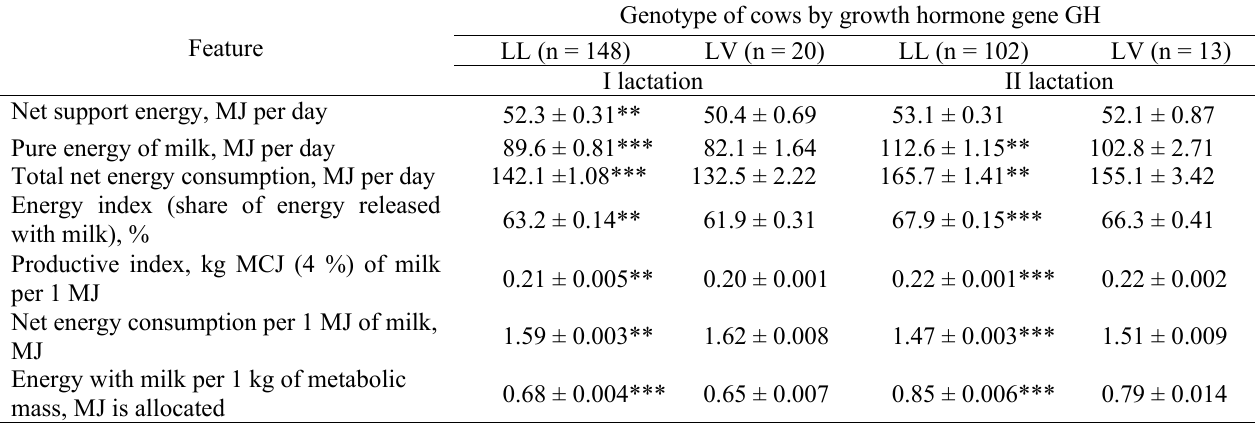
Energy evaluation of Holstein cows of different genotypes by gene GH,